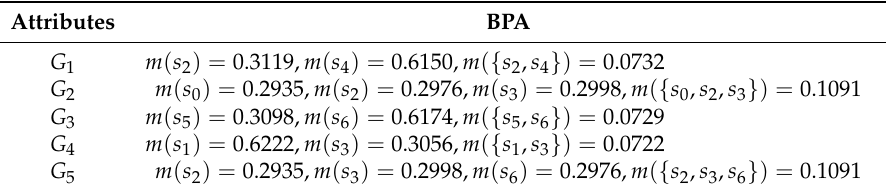
Table 14. BPAs of the attributes of A 3 .